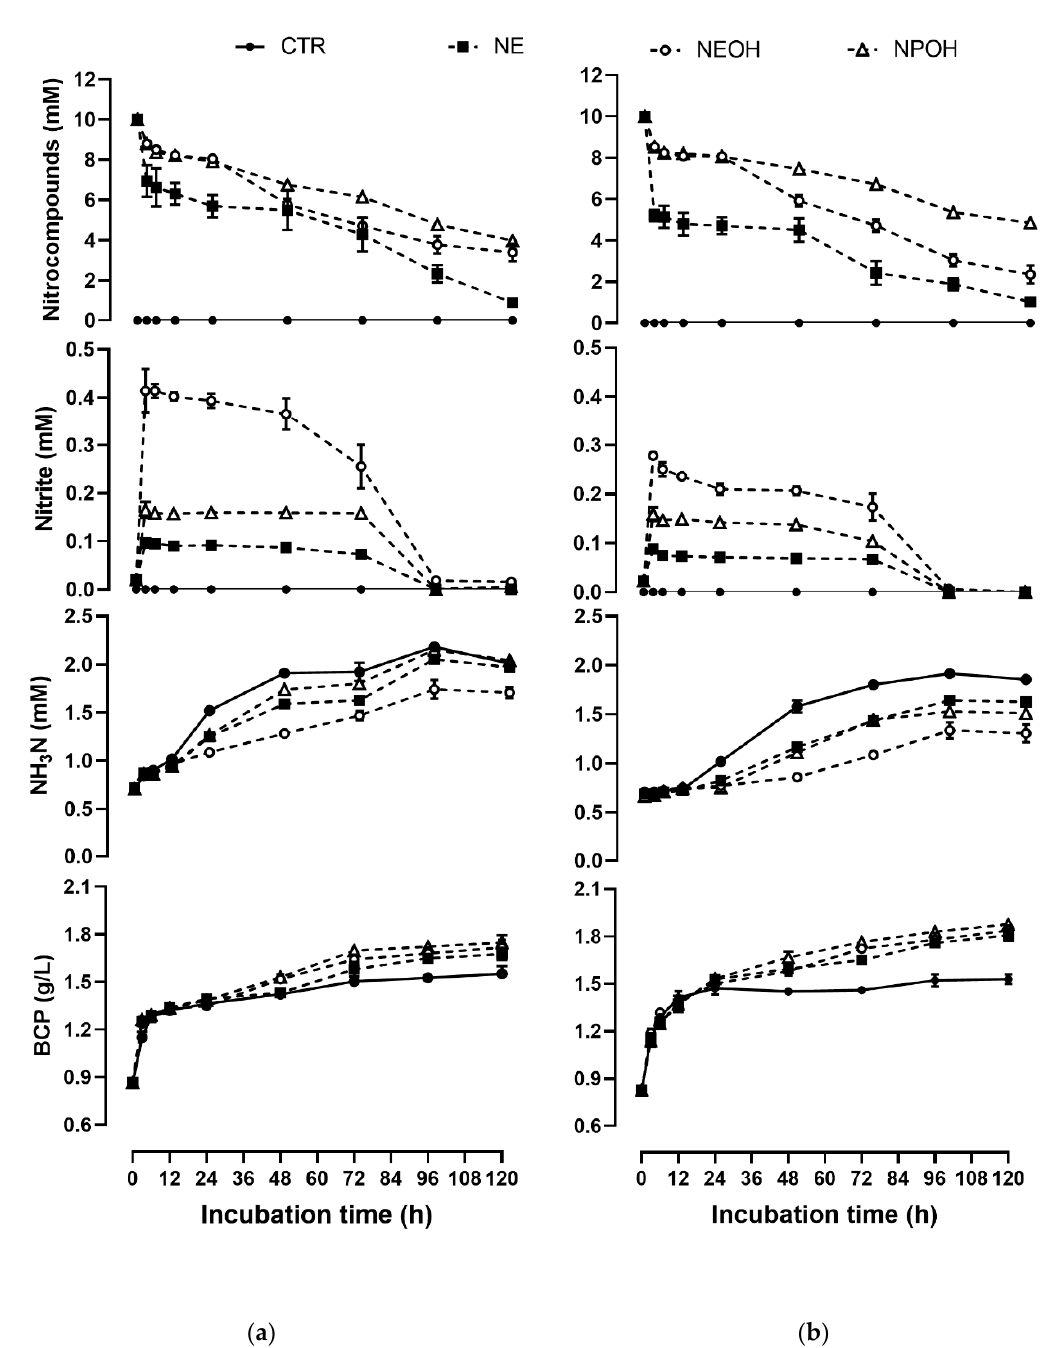
Figure 1. Variation of nitrocompounds, nitrite, ammonia N, and bacterial crude protein (BCP), on average, in culture fluids during in vitro ruminal fermentation of substrates with a high (HF, a ) and low (LF, b ) forage content incubated in batch cultures of mixed rumen microorganisms. CTR, control; NE, nitroethane; NEOH, 2-nitroethanol; NPOH, 2-nitropropional. Effect of treatments was significant at p < 0.01.